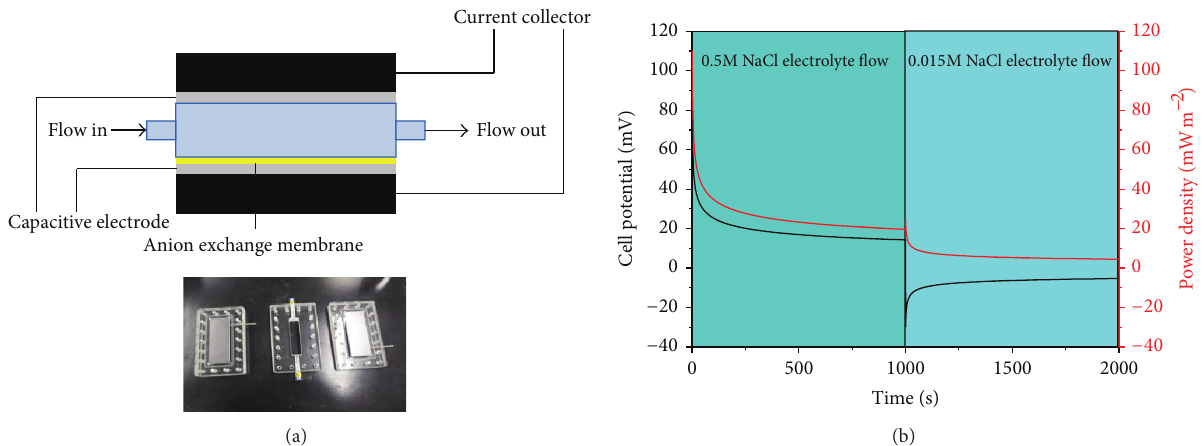
Figure 6: Photograph of the CDP device flow system with AEMs (a) and cell potential (mV) and power density (mW/m 2 ) according to time (b) for 0.5 M NaCl electrolyte flow as charging and 0.015 M NaCl electrolyte flow as discharging.